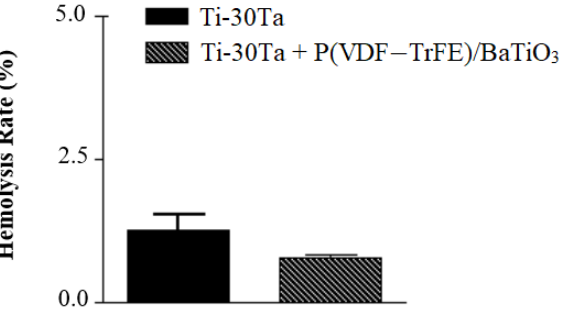
Figure 15. Hemolysis rate of Ti-30Ta alloy without the coating process and after coating process with p < 0.05. Both surfaces do not present hemolytic activity indicating they are hemocompatible.